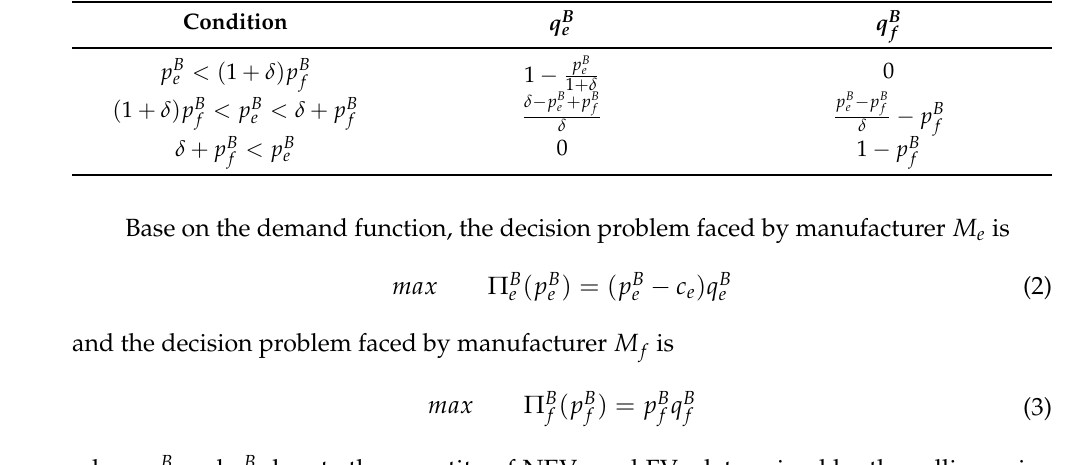
Table 2. Sales quantities of firms under the basic